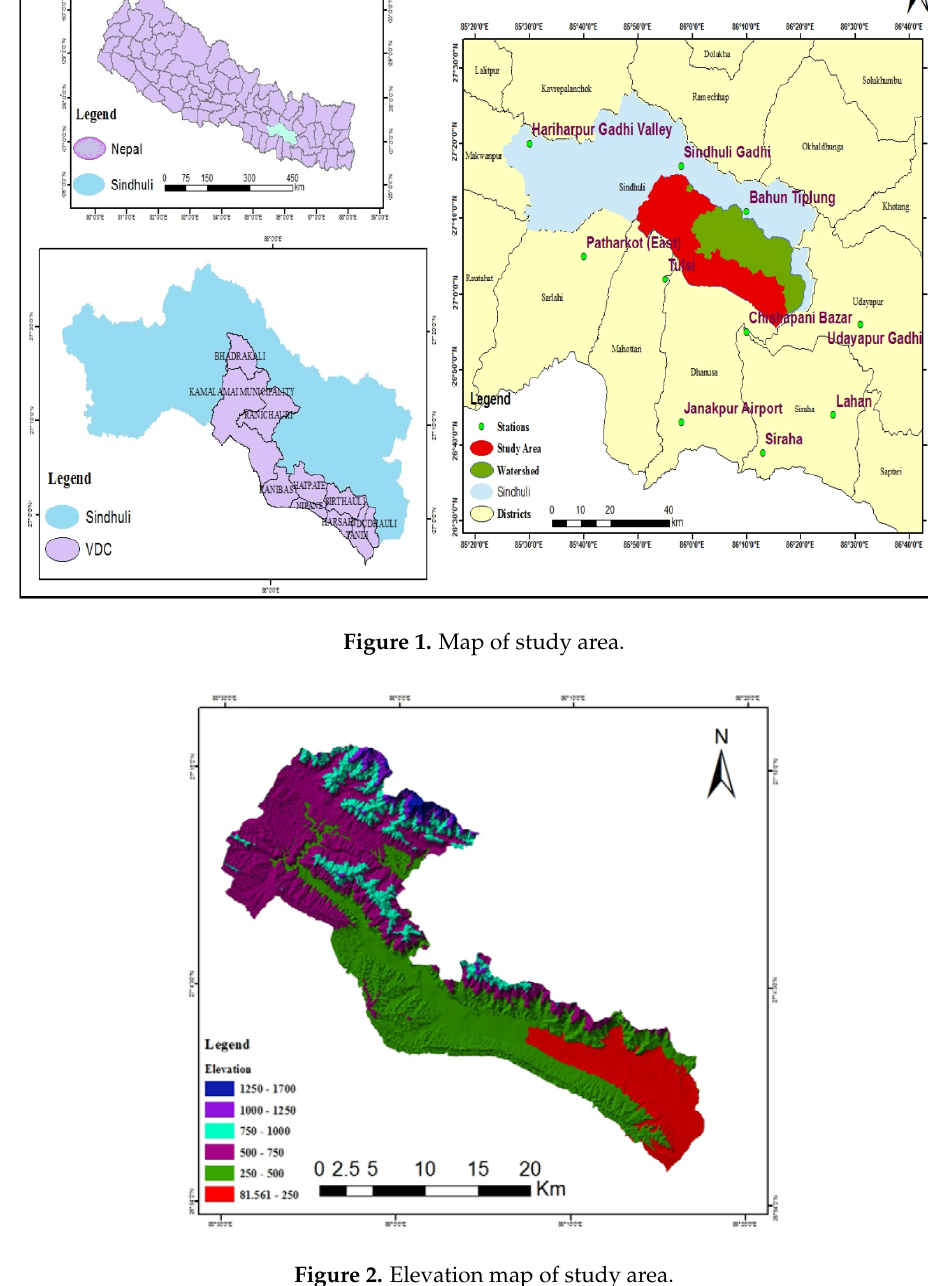
Figure 2 . Elevation map of study area.